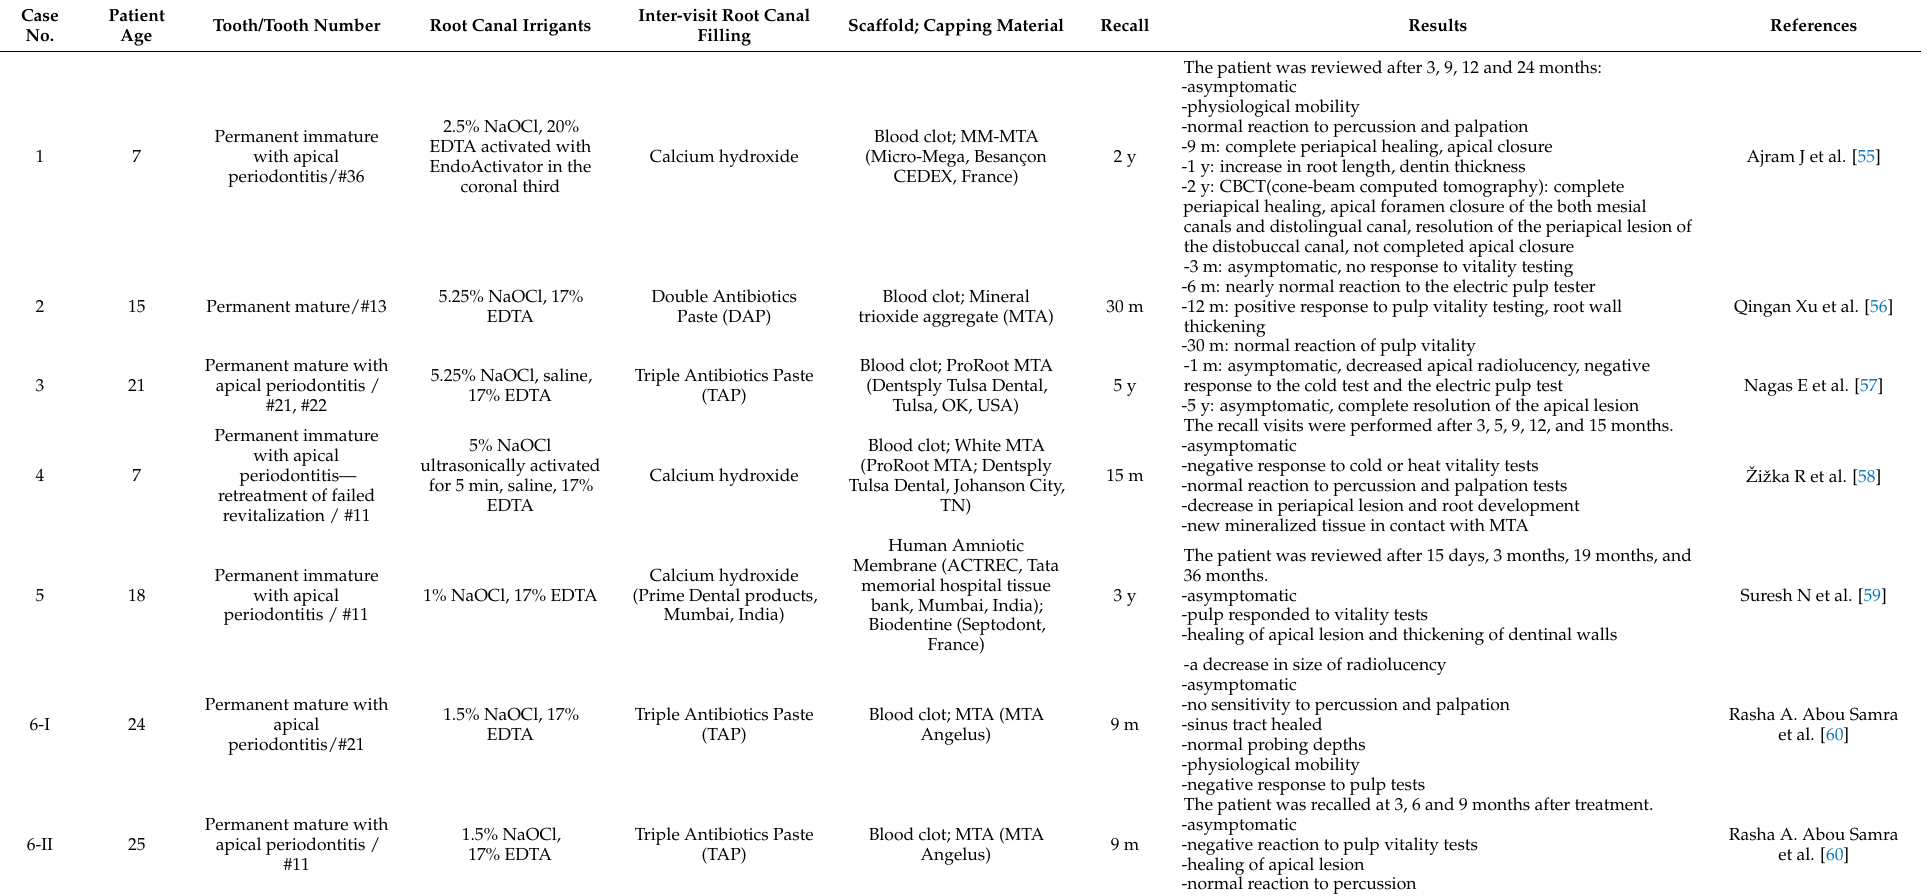
Table 1. Retrieved data from the studies that met the inclusion